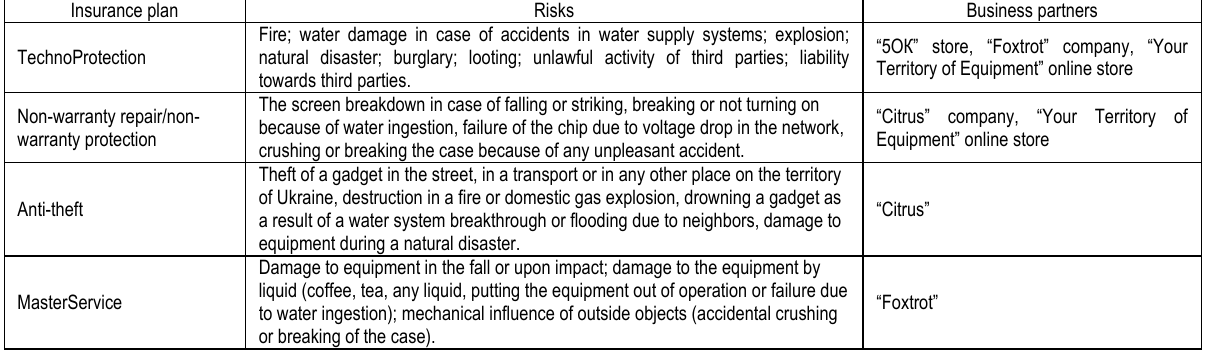
Table 1. List of partner programs “Home Appliances Insurance” of the company “Arsenal Insurance”